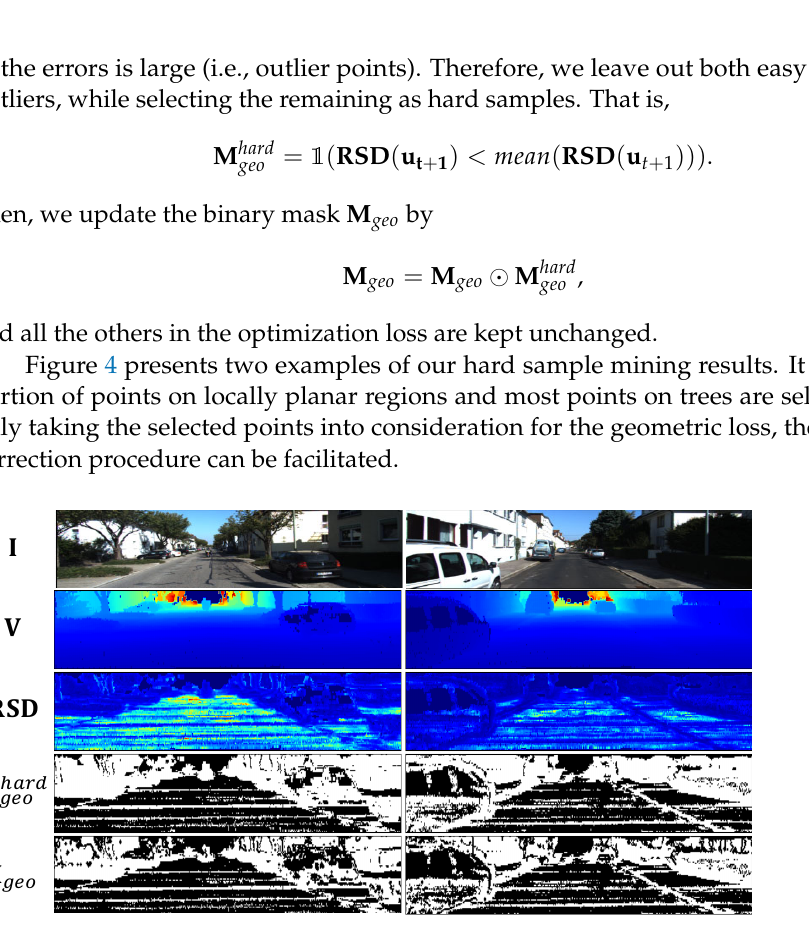
Figure 4. Typical examples in sequence 00 of KITTI. The visual image I , vertex map V , relative standard deviation (RSD), hard sample mining result M hard geo , and the updated M geo are